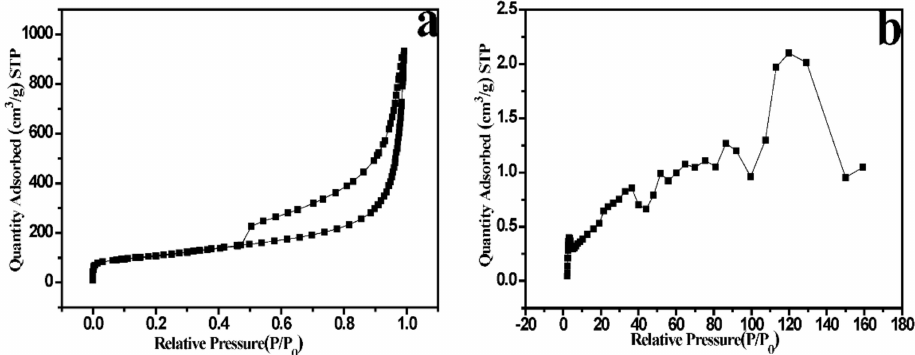
Figure 2. Nitrogen adsorption–desorption isotherms ( a ) and the corresponding pore-size distribution curve ( b ) of